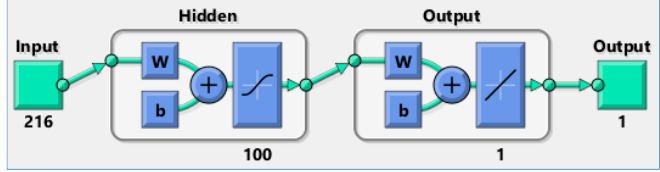
Figure 8. ANNs structure for EIT-UST hybrid data.